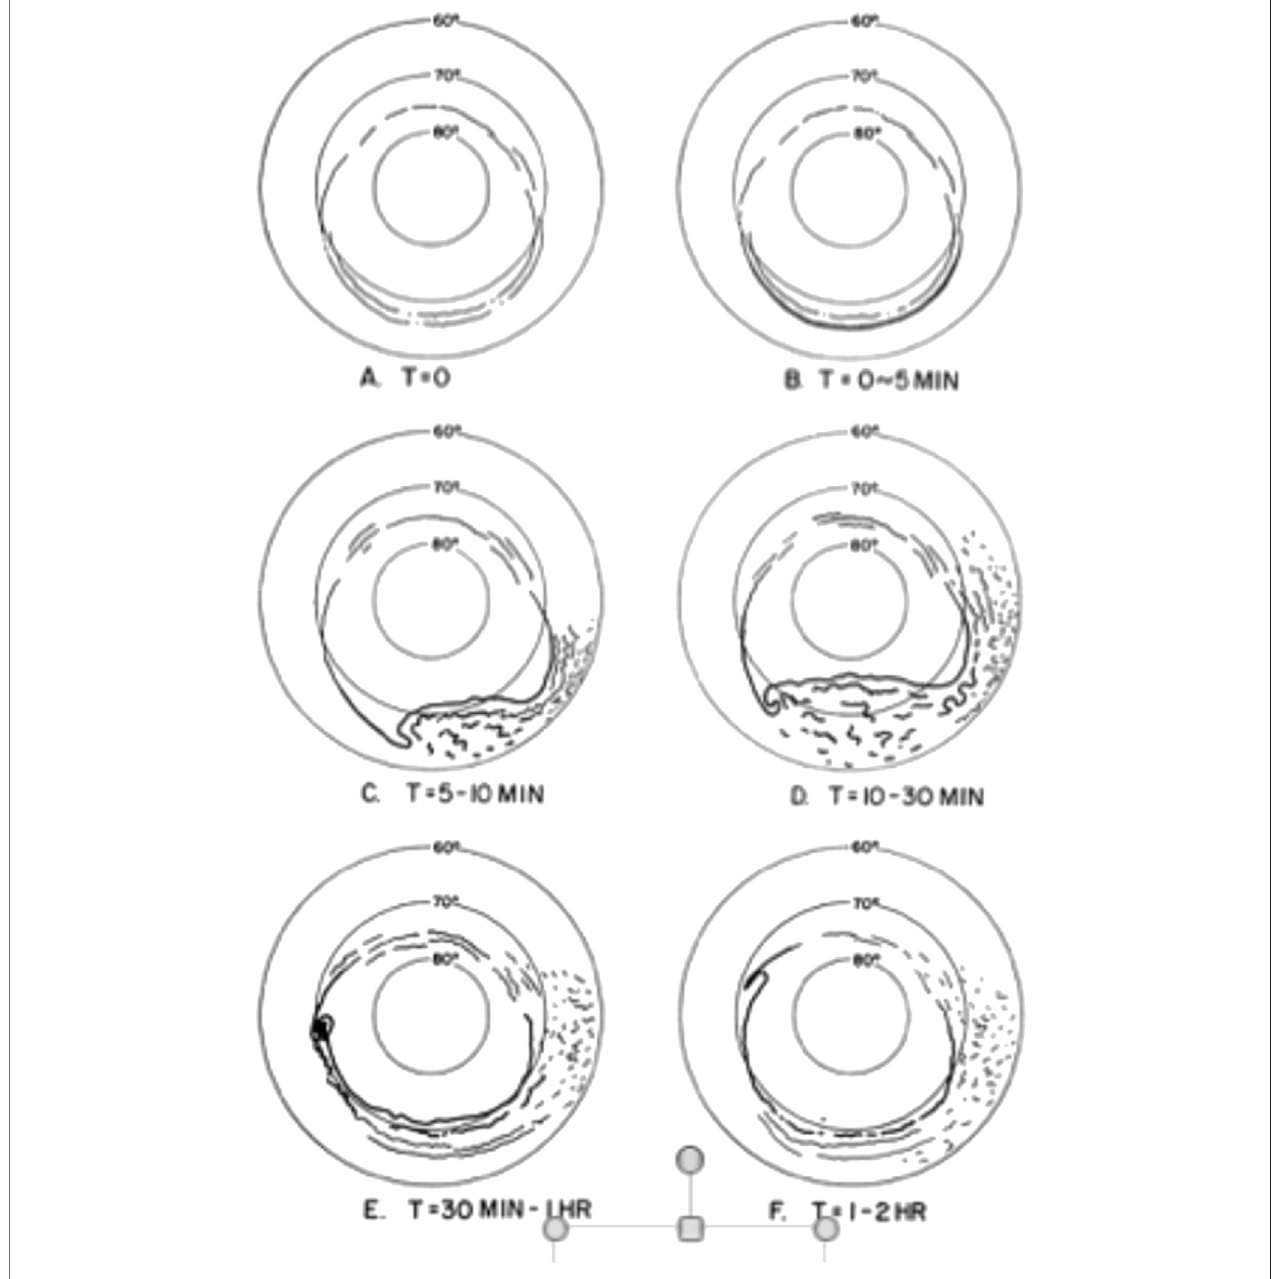
FIGURE 8 | A schematic representation of auroral activities during the expansion phase of auroral substorms (Akasofu, 1964).